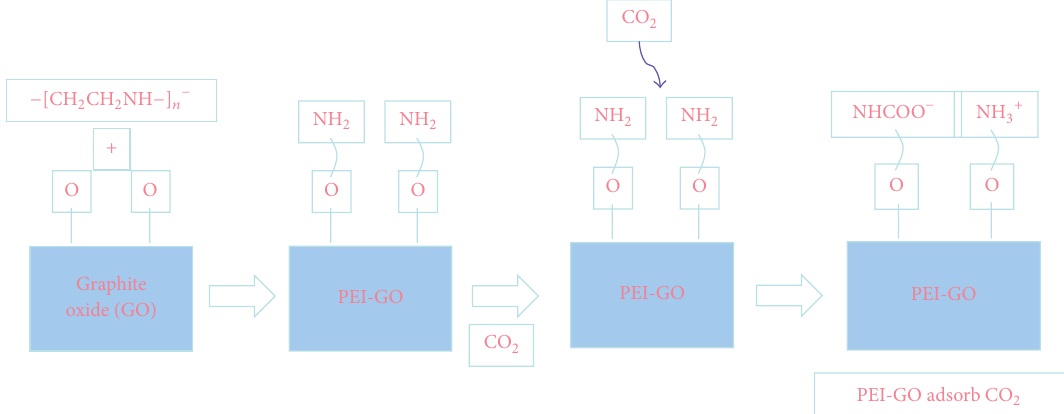
Figure 6: Effect of CO 2 capture of impregnated-graphite oxide by polyethylenimine.